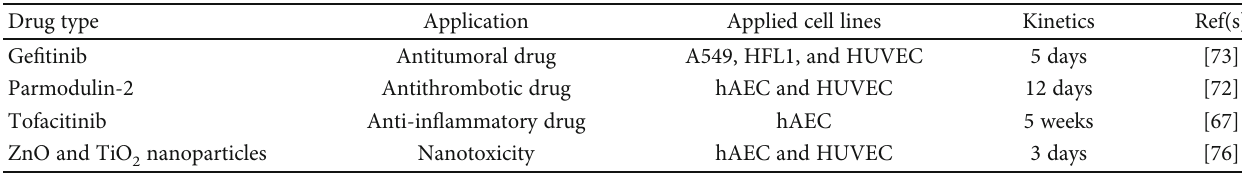
Figure 9: Design of the lung-on-a-chip. (a) In vivo, inspiration is controlled by the diaphragm. (b) In vitro, the 3D cyclic mechanical strain of the bioarti fi cial alveolar membrane (A) induced by a microdiaphragm; (B) the bioarti fi cial alveolar membrane is shown in the upper microscope picture. (c) The fl uidic part consists of (i) alveolar cell culture wells, (ii) membranes, (iii) basolateral chambers, (iv) microdiaphragms, and (v) pneumatic microchannels. (d) Photograph of the lung-on-a-chip (scale bar, 10mm). Reproduced (or adapted) with permission [69], ©2015, Royal Society of Chemistry. Table 3: Summary of recent advancements in lung-on-a-chip systems including the type of drug, the application, the applied cell lines, and